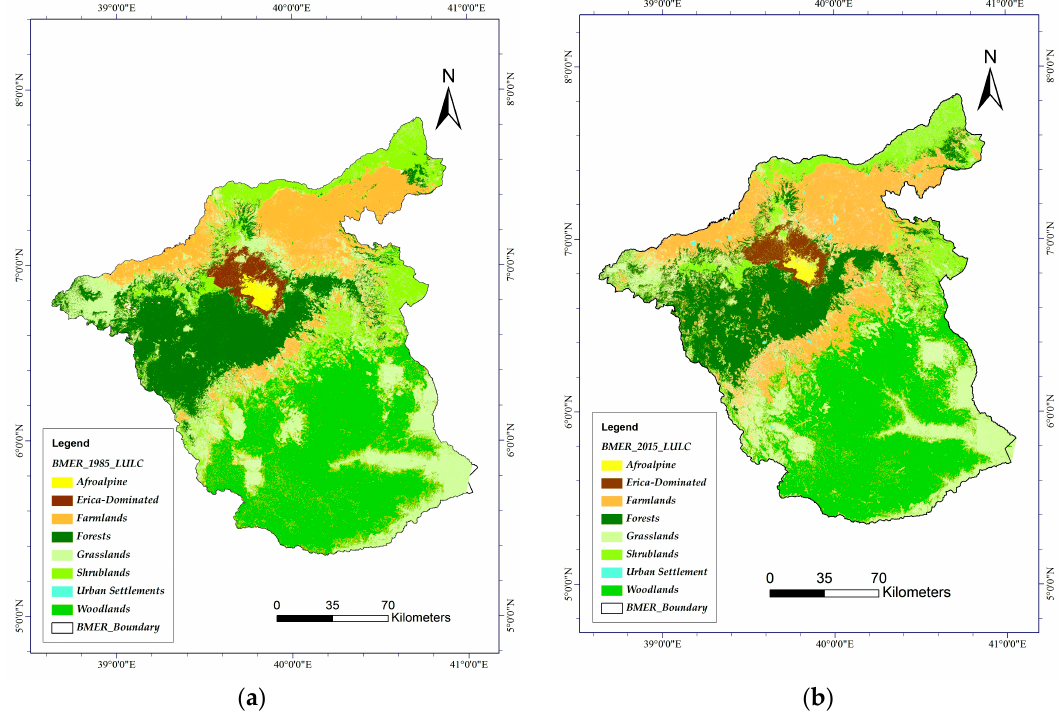
Figure 4. A comparative map showing the actual LULCC in BMER in 1985 ( a ) and 2015 ( b ). Table 4. Extent of LULCC (area in ha) during